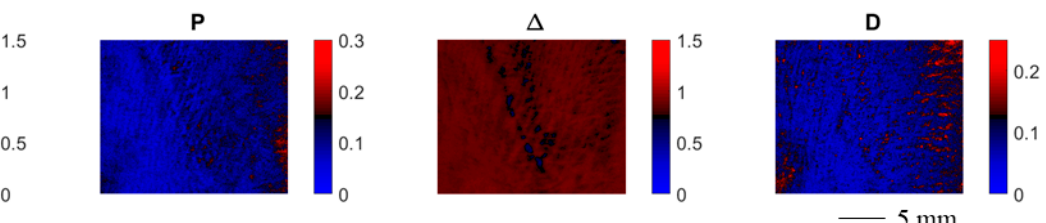
Figure 5. Spatially resolved polarimetric parameters for an exemplary hypertrophic scar. Each polarimetric parameter provides a certain degree of contrast between the scarred and the healthy skin area.